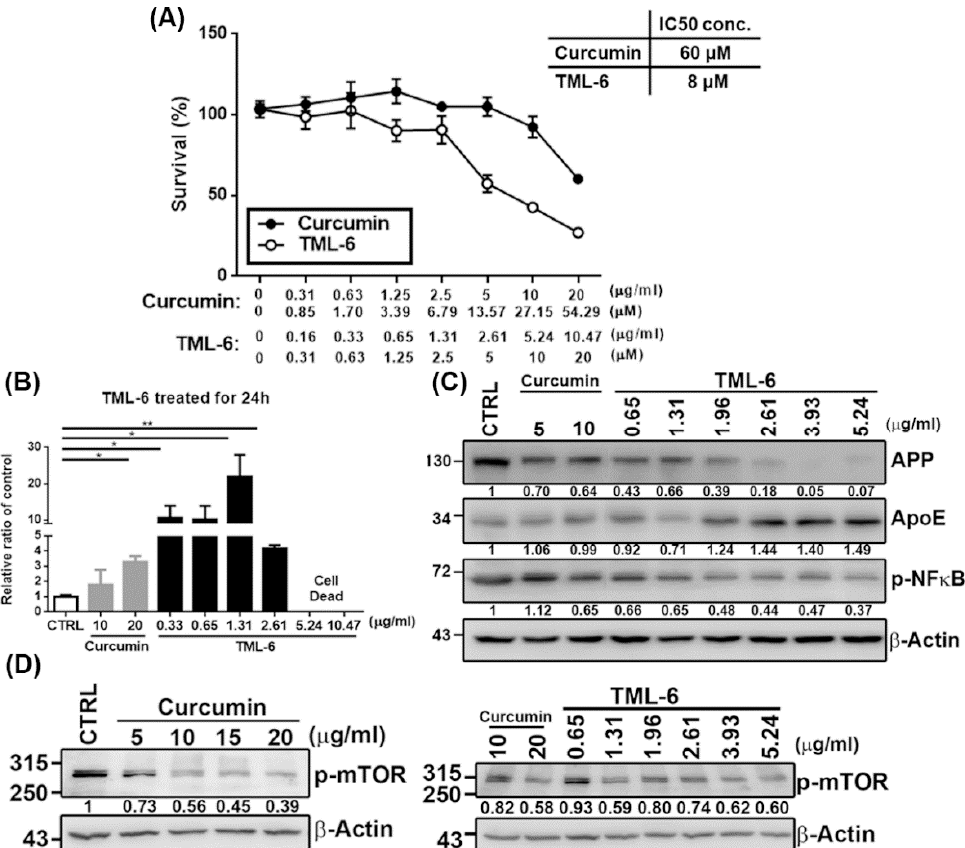
Figure 2. The cytotoxicity studies, inhibitory concentration (IC)50, and biologic studies of TML-6. TML-6 could transcriptionally activate the Nrf2 promoter, suppress the expression of the amyloid precursor protein (APP) and phospho-NF- κ B, and in contrast, increases the ApoE and phospho-mTOR expression in Huh-7 cell line. ( A ) The cytotoxicity (IC50 assay) of traditional curcumin and TML-6 were examined by CCK-8 in Huh-7 cells for 24 h. The working concentration of traditional curcumin and TML-6 was expressed in µ M and µ g / mL separately for comparison. The IC50 of curcumin and TML-6, 60 and 8 µ M, respectively, is expressed at the right side of Figure 2A. In the following studies, the dose concentration was expressed in µ g / mL only, as indicated in Figure 2B–D. ( B ) The luciferase plasmid contains the Nrf2 promoter co-transfected with pRL-TK (Renilla) into Huh-7 cells by Lipofectamine 2000. Transfected cells were treated with curcumin and TML-6 for 24 h, and the Nrf2 promoter activity was analyzed by the Dual-Luciferase Report assay system. TML-6 could exhibit transcriptional activation of the Nrf2 gene in a dose-dependent manner, with the highest activity at a concentration of 1.32 µ g / mL, which was 12.1- and 6.6-fold stronger than the traditional curcumin at a dose of 10 and 20 µ g / mL, respectively. Data represent the mean with a standard deviation (SD) error bar and p value < 0.05 was considered significant (* p < 0.05, ** p < 0.01). The Nrf2 promoter plasmid revealed a higher cytotoxicity beyond 5.24 µ g / mL. ( C ) Huh-7 cells were treated with di ff erent doses of traditional curcumin and TML-6 for 24 h. Western blotting was performed to examine Alzheimer’s-related protein molecules such as APP, Apo E, inflammatory marker-phosphorylated NF- κ B ( C ), and phosphorylated mTOR ( D ). The quantification of protein expression levels in APP, ApoE, p-NFkB and p-mTOR were normalized by β -Actin and are shown as fold induction in comparison to the untreated control (CTRL) under immunoblotting data in each panel. These AD biomarker proteins revealed a dose-dependent manner in response to TML-6 treatment.